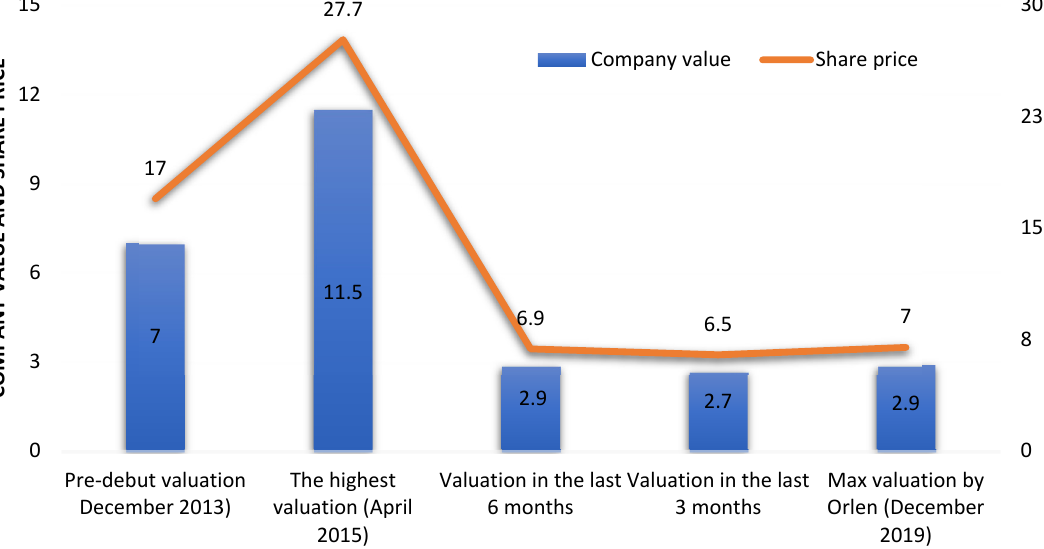
Figure 5. Market value of the Energa concern before the merger by PKN ORLEN. Source: author’s study based on https://wysokienapiecie.pl/24792-orlen-chce-przejac-energe/ (access date: 15 August 2021).